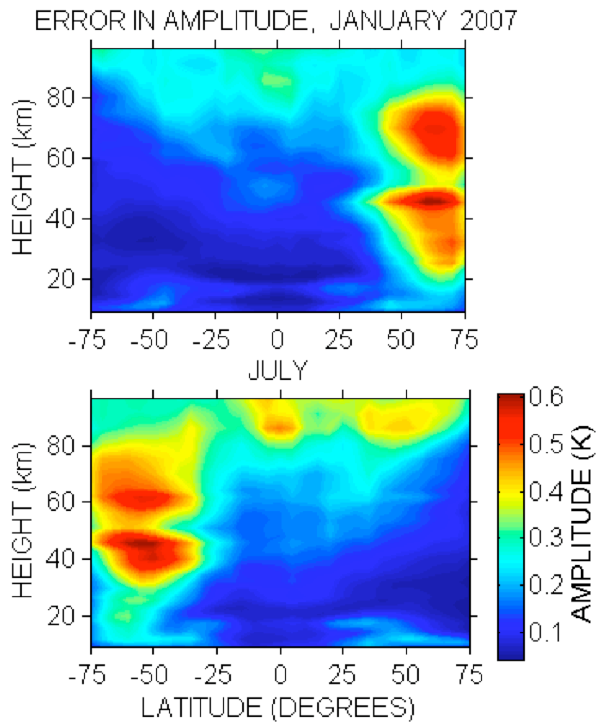
Fig. 3. Least-squares fit error in the wave amplitudes for January and July 2007 using a 95% confidence